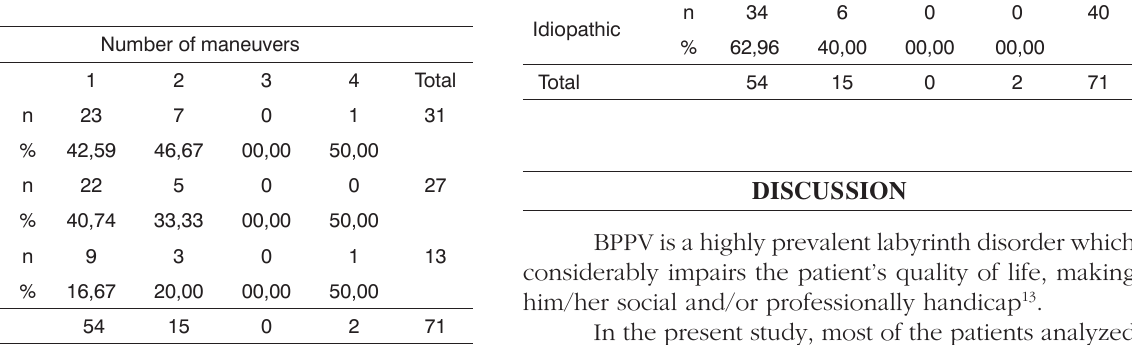
Table 2. Crossing the number of maneuvers and age variables